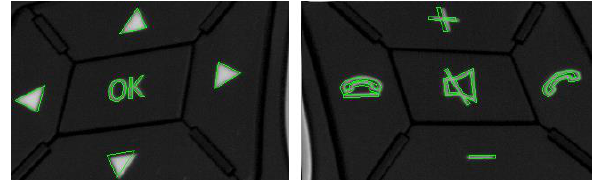
Figure 5. Matching results of the CAD model (green)